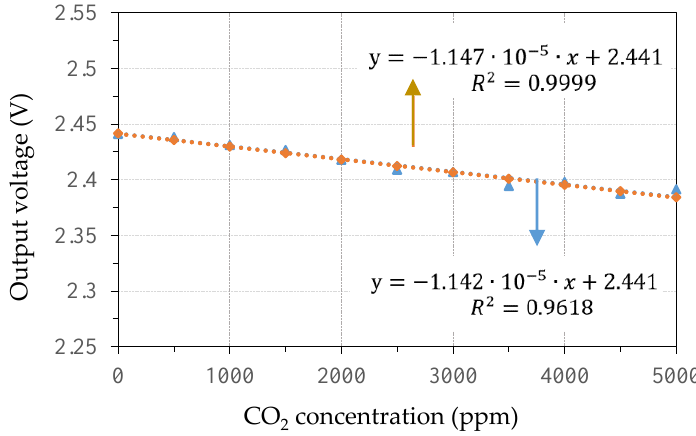
Figure 13. Calibration verification function between gas concentration and output